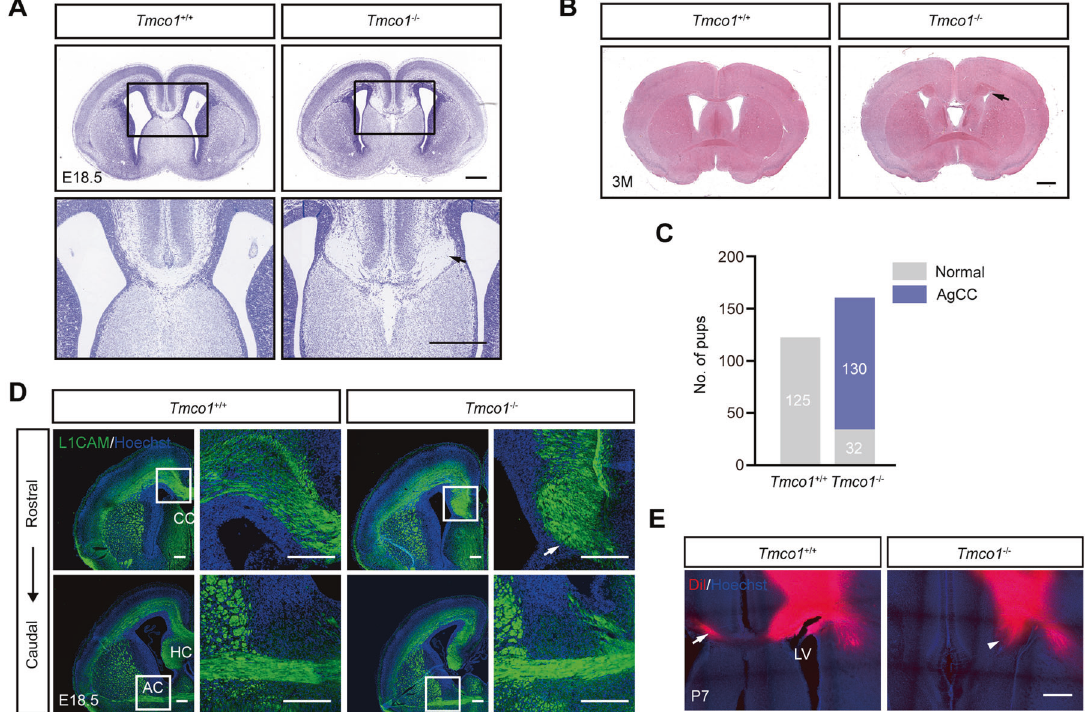
Fig. 1 Defects in the formation of the corpus callosum and hippocampal commissure in developing brains of Tmco1 − / − mice. A Nissl staining of coronal sections of Tmco1 + / + and Tmco1 − / − brains at E18.5. Lower panels, high magni fi cation of the areas boxed in the upper. Arrow indicates the agenesis of the corpus callosum (AgCC) in Tmco1 − / − brains. Scale bar, 500 μ m. B H&E staining of coronal sections of Tmco1 + / + and Tmco1 − / − brains at 3 months old. Arrow indicates the abnormal corpus callosum in Tmco1 − / − . Scale bar, 1000 μ m. C Quanti fi cation of the number of pups with the AgCC phenotype in Tmco1 + / + and Tmco1 − / − . Gray indicates normal CC while purple indicates AgCC. D L1CAM immuno fl uorescence (green) in Tmco1 + / + and Tmco1 − / − embryos at E18.5 in rostral and caudal coronal sections showing the developing CC region, hippocampal commissure and anterior commissure. High magni fi cation of the areas boxed are shown on the right. Arrow indicates the AgCC. Scale bar, 200 μ m. CC corpus callosum, HC hippocampal commissure, AC anterior commissure. E Callosal axons projection pattern monitored by DiI crystals (red), which was injected in the cortex of one hemisphere and allowed to diffuse via callosal axons to the contralateral hemisphere in P7 Tmco1 + / + or Tmco1 − / − mice. Scale bar, 500 μ m. Arrow, the correctly projected callosal axons to the contralateral hemisphere in Tmco1 + / + ; arrowhead, Probst bundles formed in Tmco1 − / − . LV lateral ventricle. See also Fig.